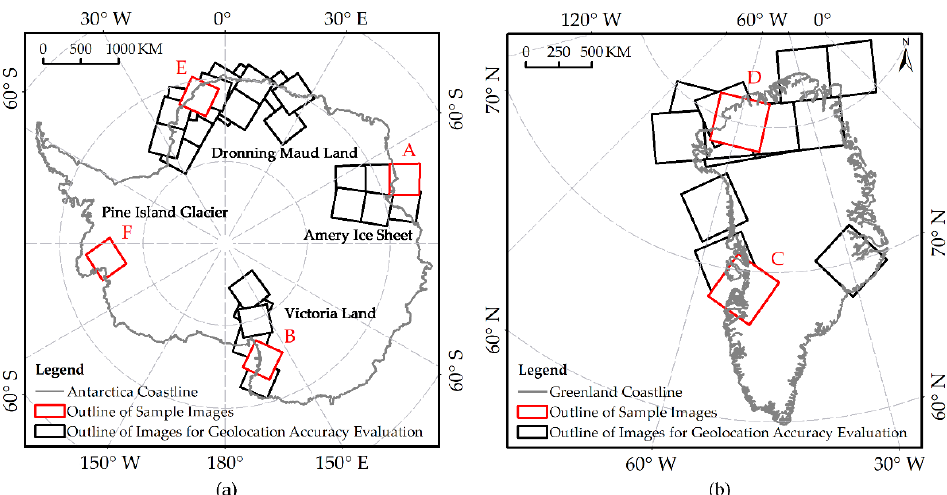
Figure 1. Distributions of the sample images of BNU-1 for ( a ) Antarctica and ( b ) Greenland. Black and red rectangles refer to the footprints of 43 sample BNU-1 image scenes, in which red rectangles show the 6 Sample Images (A–F) used for the analysis in this study. Sample Images A–F were acquired for the Amery Ice Shelf on 8 October 2019, Victoria Land on 11 October 2019, Greenland on Glacier on 28 December 2019,